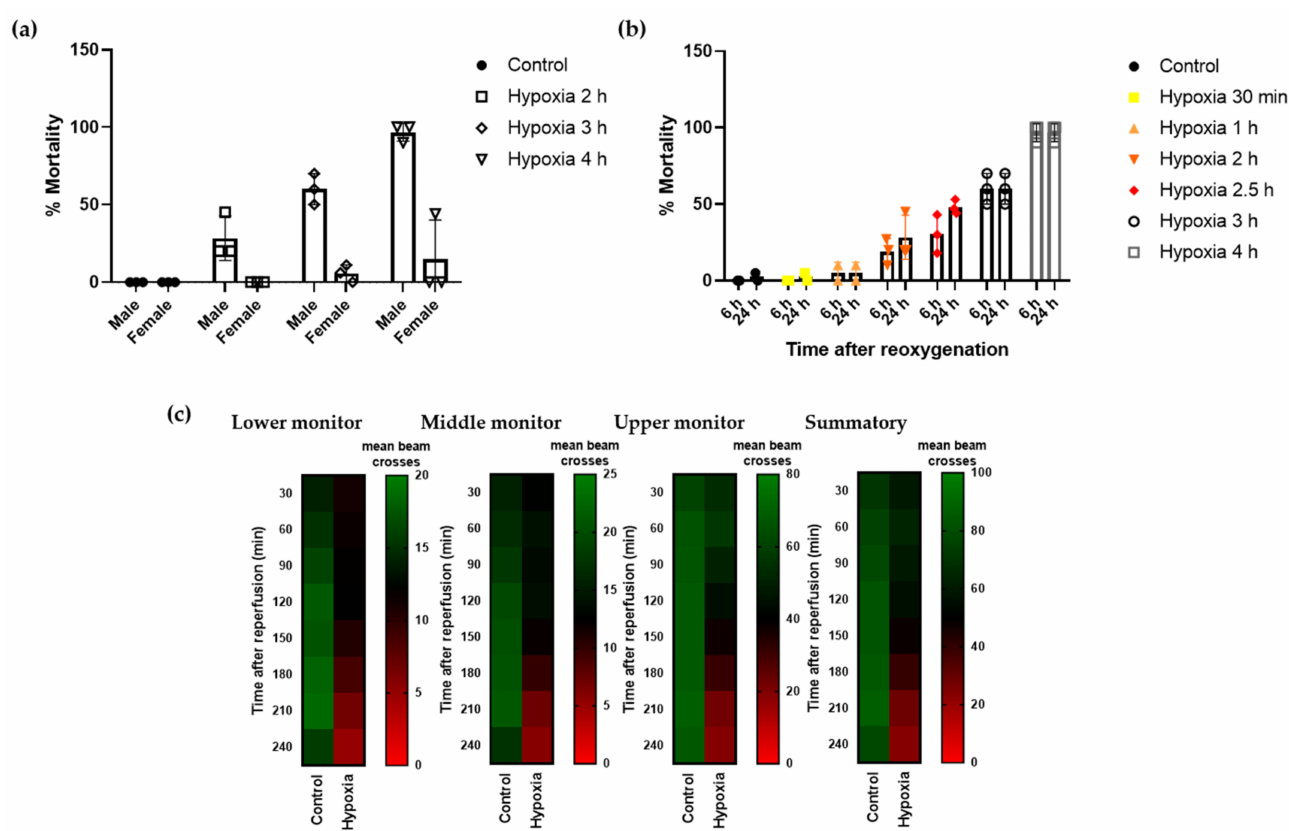
Figure 1. Mortality rate and locomotor activity of Drosophila after hypoxia. Flies were submitted to 1% O 2 for different time periods followed by reoxygenation (n = 3 experiments, 90 individuals per condition). ( a ) Mortality rate of male and female flies 24 h after exposure to different durations of hypoxia. ( b ) Mortality rate of male flies 6 and 24 h after hypoxia exposure. ( c ) Heatmap displaying the locomotor activity of male flies following 2.5 h of hypoxia or normoxia. Flies were transferred into the DAM system immediately after hypoxia and activity was recorded for 240 min after reperfusion. Each cell shows the mean beam crosses per